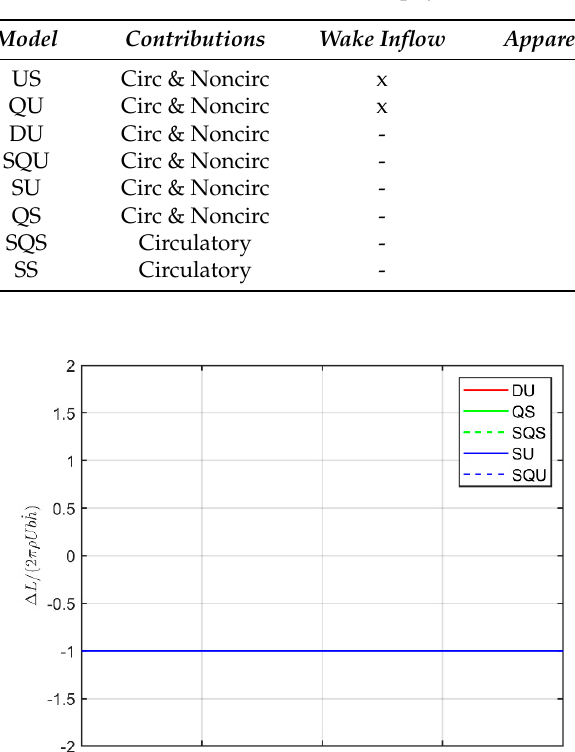
Table 1. Main physical features of the presented aerodynamic models.